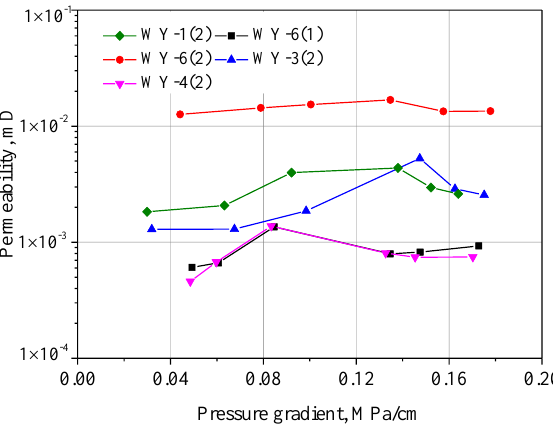
Figure 6. Relationship between pressure gradient and permeability of five shale samples.